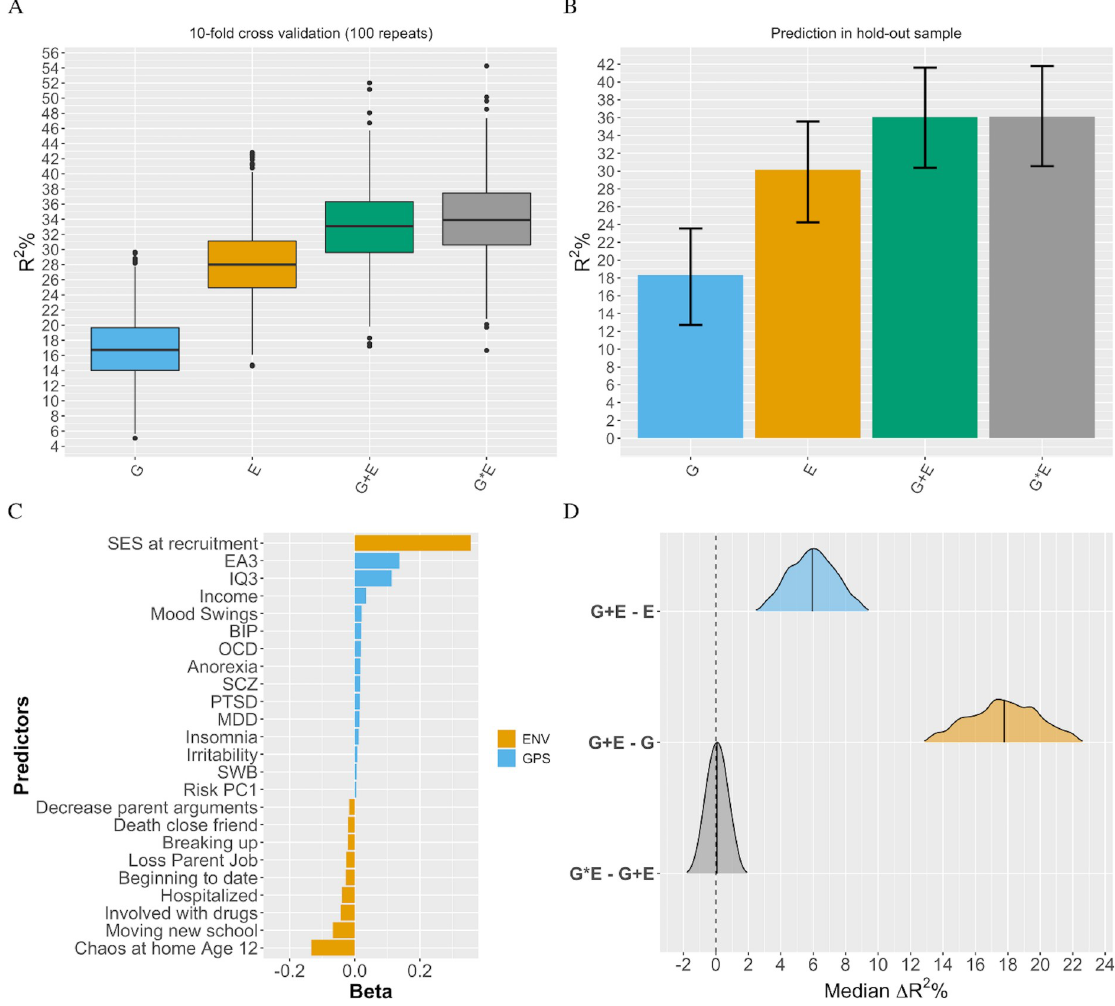
Fig 1. Multivariable prediction of educational achievement. Panel A = repeated 10-fold cross validation in training set, for the environmental (E), multi-polygenic score (G), joint (G+E), and interaction (G � E) prediction models. Panel B = Hold-out set prediction of EA for best models obtained via repeated cross validation in training set. Error bars are 95% bootstrapped confidence intervals. Panel C = G +E model used in hold-out set prediction. Figure shows variables selected via repeated cross-validation in the training set, and relative importance. Panel D = Comparison of prediction accuracy for models tested as bootstrapped R 2 difference between nested models in the hold-out set. Distributions represent independent (non-mediated) genetic effects (G+E − E), environmental effects (G+E − G), and G � E effects (G � E–G+E). Note. PGS = polygenic scores, ENV = Environmental measures. ASD = Autism Spectrum Disorder, BIP = Bipolar Disorder, BMI = Body Mass Index, EA3 = Educational Attainment, IQ3 = Intelligence, OCD = Obsessive Compulsive Disorder, PTSD = Post-Traumatic Stress Disorder, SCZ =